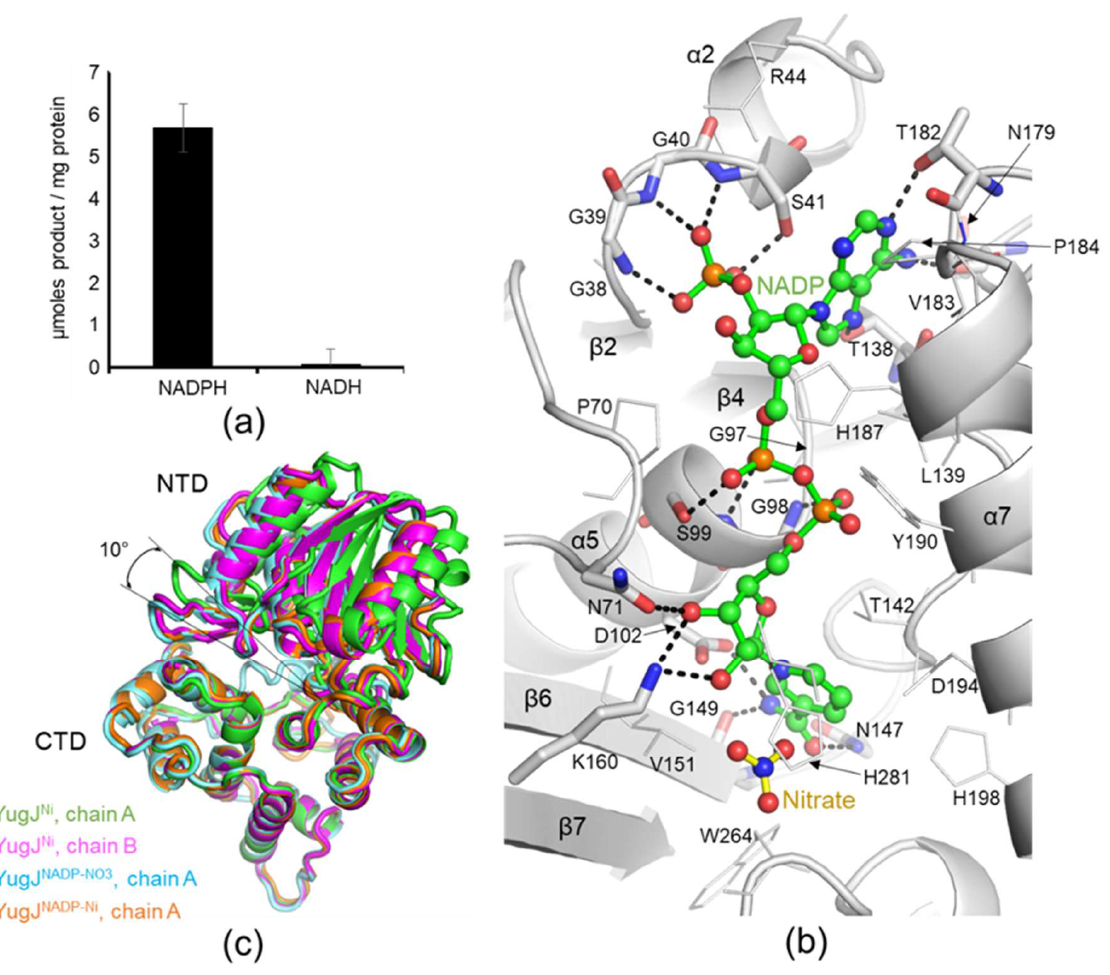
Figure 3. NADP recognition by YugJ. ( a ) NADPH-dependent HMF reduction by YugJ. The HMF reduction activity of YugJ was determined in the presence of NADPH or NADH as a cofactor. ( b ) NADP-binding site of YugJ in the YugJ NADP-NO3 structure. The NADP cofactor (carbon, green sphere; nitrogen, blue sphere; oxygen, red sphere; phosphorus, orange sphere; interatomic bond, green stick) and its neighboring nitrate ion (nitrogen, blue sphere; oxygen, red sphere; interatomic bond, yellow stick) are represented by ball-and-stick models. The NADP-binding residues of YugJ are shown as gray lines on the YugJ structure (gray ribbons). In particular, the YugJ residues that form polar interactions with NADP are depicted as gray sticks. ( c ) NADP binding-mediated restriction of YugJ interdomain flexibility. The YugJ Ni (chain A, green ribbons; chain B, magenta ribbons), YugJ NADP-NO3 (cyan ribbons), and YugJ NADP-Ni (orange ribbons) structures are superimposed based on their